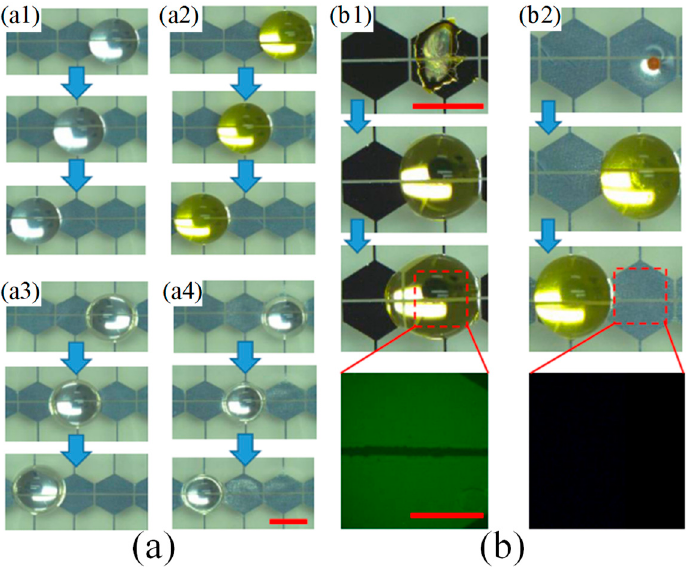
Figure 13. ( a ) Different liquids transported on EWOD-SLIPS surfaces: (a1) Deionized (DI) water, (a2) Bovine serum albumin (BSA) solution, (a3) propylene carbonate, (a4) isopropyl alcohol. ( b ) A droplet cleaning bio-stains left by evaporation: (b1) droplet fails to move on hydrophobic coatings due to bio-fouling, (b2) droplet moves and cleans the bio-stain. The green in the fluorescent images indicate the BSA residues on the surfaces. Reproduced with permission from [136], published by IEEE, 2018.